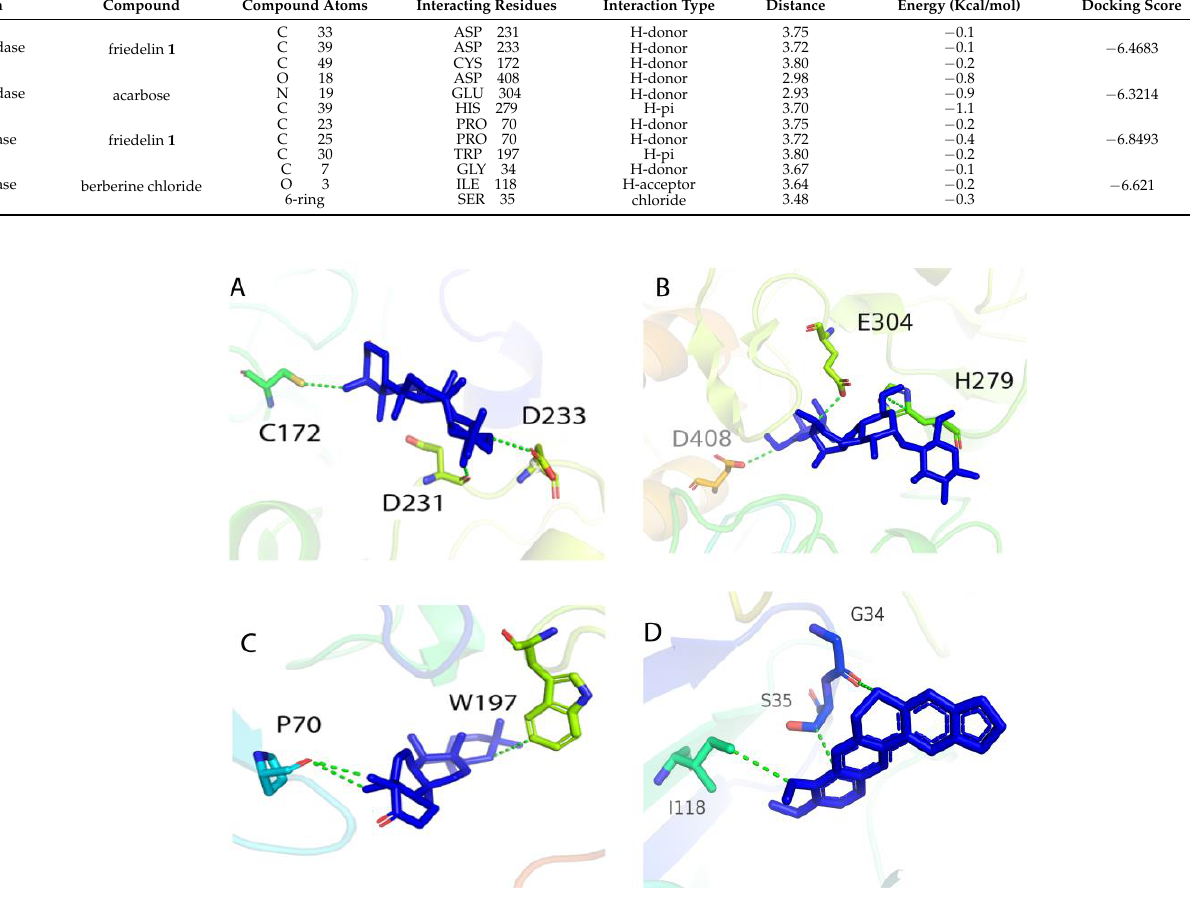
Table 5. Lipinski Rule of five.